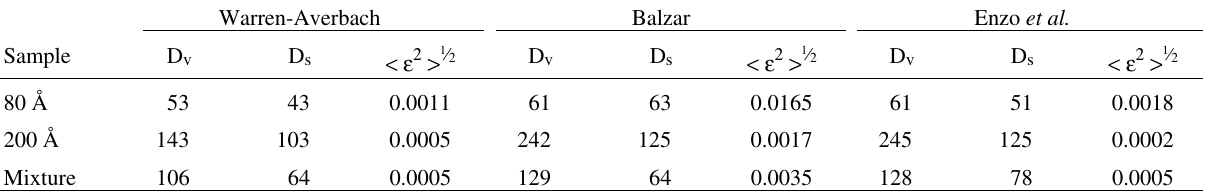
Table 2. Comparison of the defect structure parameters determined by X-Ray Diffraction for three different approaches. Warren-Averbach Balzar